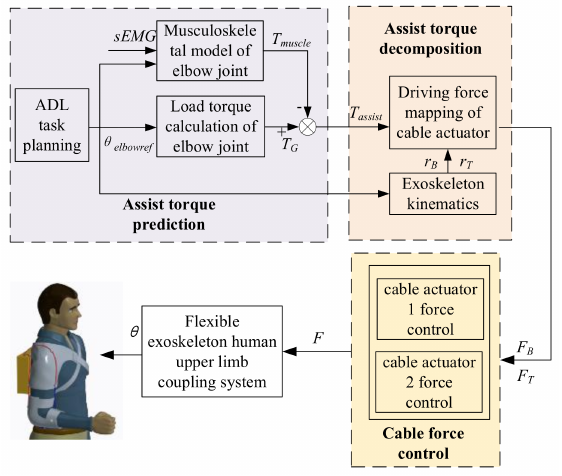
Figure 5. Assist-as-needed control system block